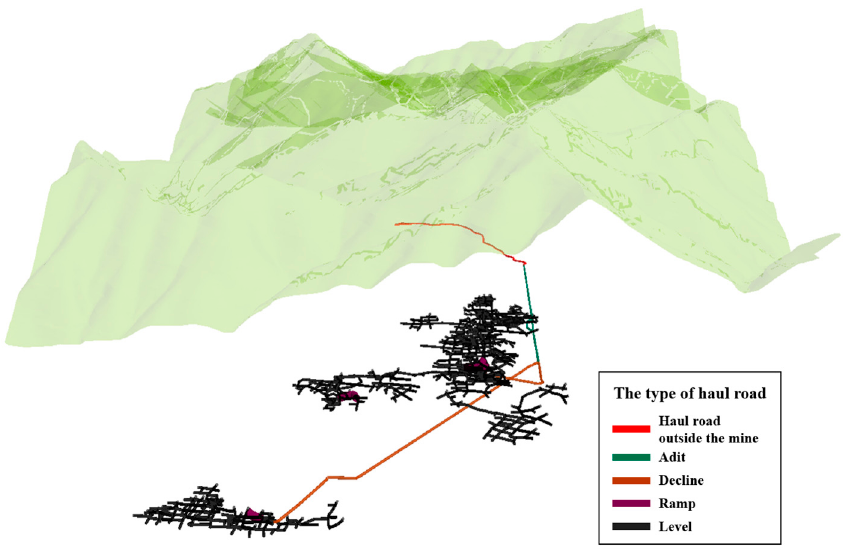
Figure 3. Three-dimensional view of haul roads constructed in the underground mine. Haul roads consist of an adit, declines, ramps, levels, and a haul road outside the mine.